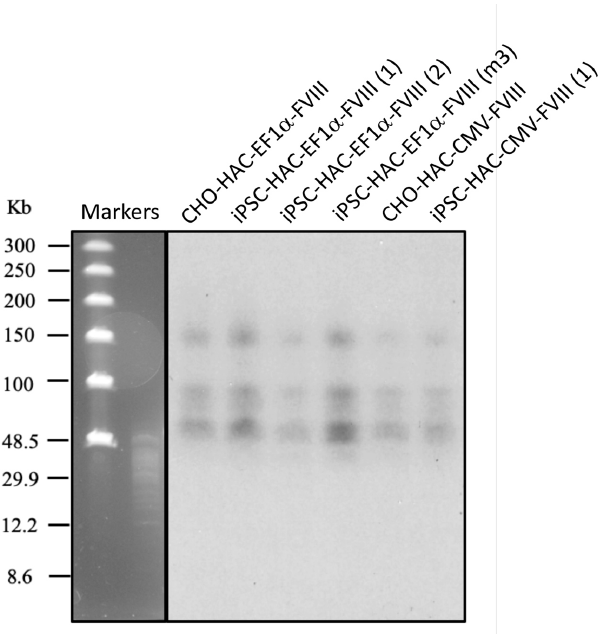
Figure 6. Southern blot assay of the alphoid tetO -HAC-FVIII integrity in hamster CHO cells (EF1 α -FVIII, CMV-FVIII constructs) and in different FVIII Y/- iPSC-HAC- FVIII cell clones: iPSC-HAC-EF1 α -FVIII(1), iPSC-HAC-EF1 α -FVIII(2), iPSC-HAC-EF1 α -FVIII(m3), iPSC-HAC-CMV-FVIII(1). Genomic